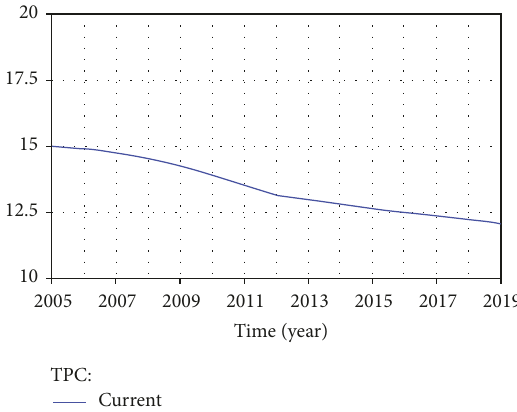
Figure 8: Relationship length (RL) trends.